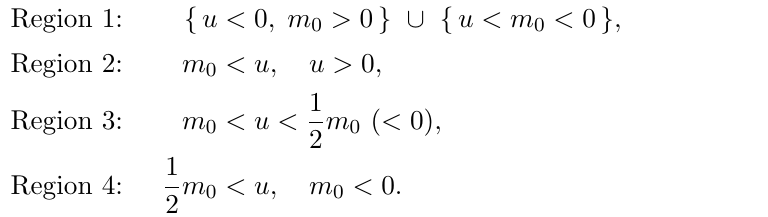
m 0 for m 0 0 and 2 (cid:20)